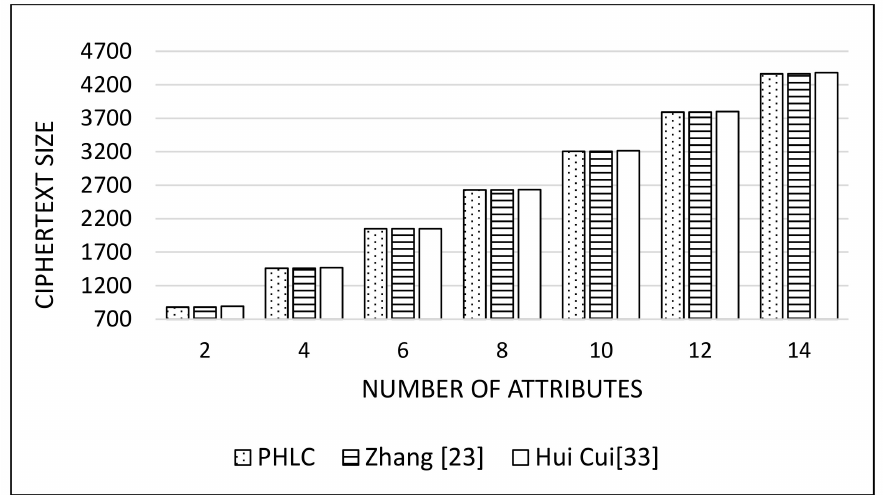
Figure 9. Storage cost of ciphertext.